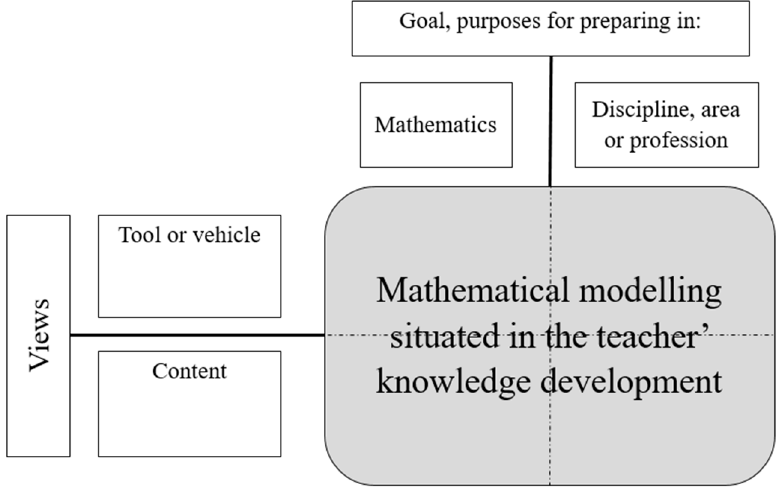
Figure 1. Representation of a perspective of the teacher’s modeling knowledge.